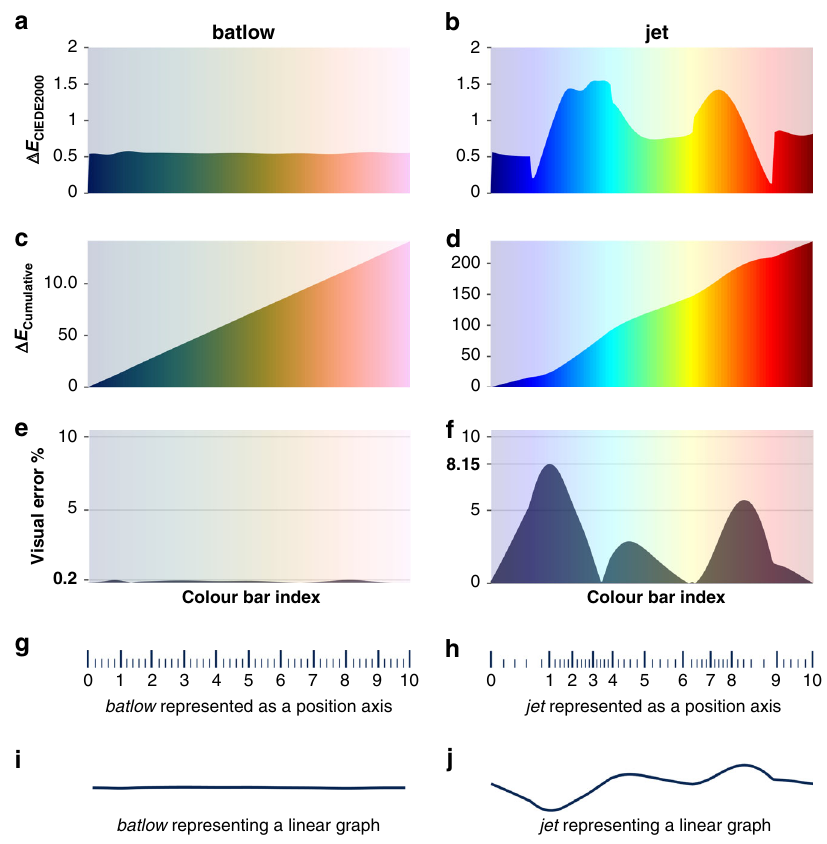
Fig. 3 Colour map measure, distortion, and error. a , b The incremental lightness difference, Δ E , here using the CIEDE 2000 formulation (see ‘ Methods ’ ), is a measure for the perceptual colour difference along the colour map. For a perceptually uniform colour map, Δ E CIEDE 2000 should be equal all along the colour map (i.e., a fl at graph; a ). Using c , d the cumulative colour lightness difference, Δ E Cumulative , it is possible to extract e , f the resulting visual error in percentage of total data variation. For scienti fi cally derived colour maps like batlow 41 , the resulting error introduced to the data by the colouring is negligibly small as g the incremental data variation is represented equally all along the axis, and a linear data gradient, therefore, appears linear. Put differently, i a fl at line looks fl at. For non-scienti fi c colour maps, like jet, h data gradients are unevenly represented and f visual error can be >7% of the displayed data variation such that j a linear graph (e.g., a fl at line), for example, becomes